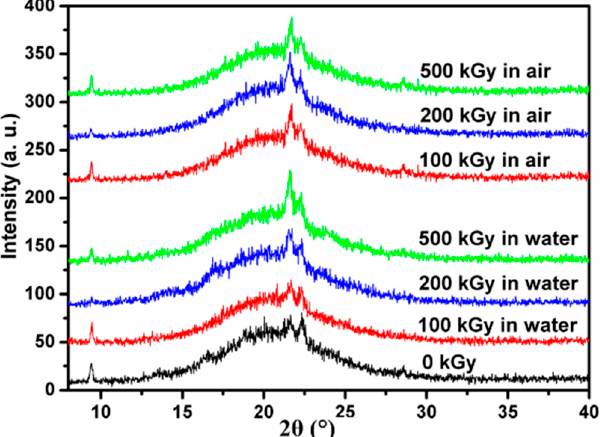
Figure 6. XRD patterns of the Estane samples irradiated at doses of 0, 100, 200 and 500 kGy in air and water.